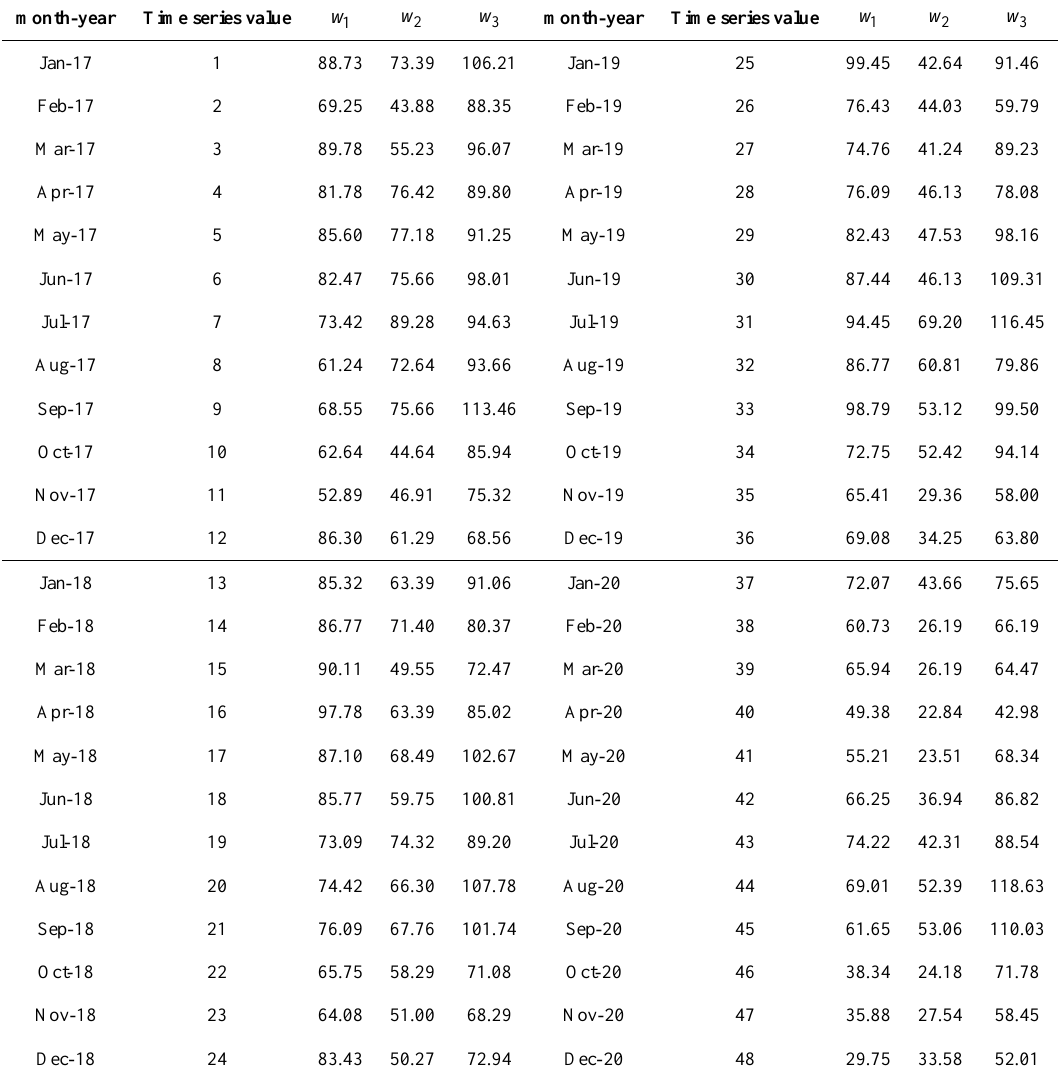
Table 2. The monthly rate of food poisoning incidence per 100,000 elderly people from January 2017 – December 2020.